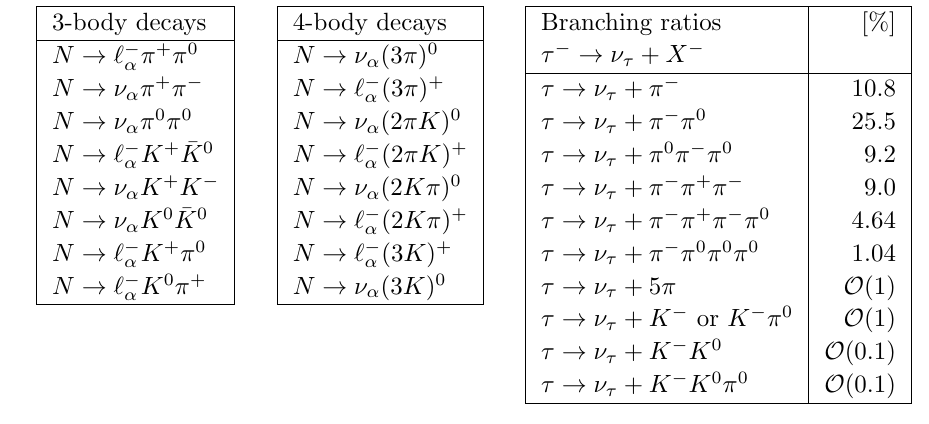
Table 4 . Possible multi-meson decay channels of HNLs with M N > 2 m (cid:25) threshold. Right panel shows branching ratios of hadronic decays of (cid:28) -lepton and demonstrates relative importance di(cid:11)erent hadronic 2, 3, 4 and 5 body